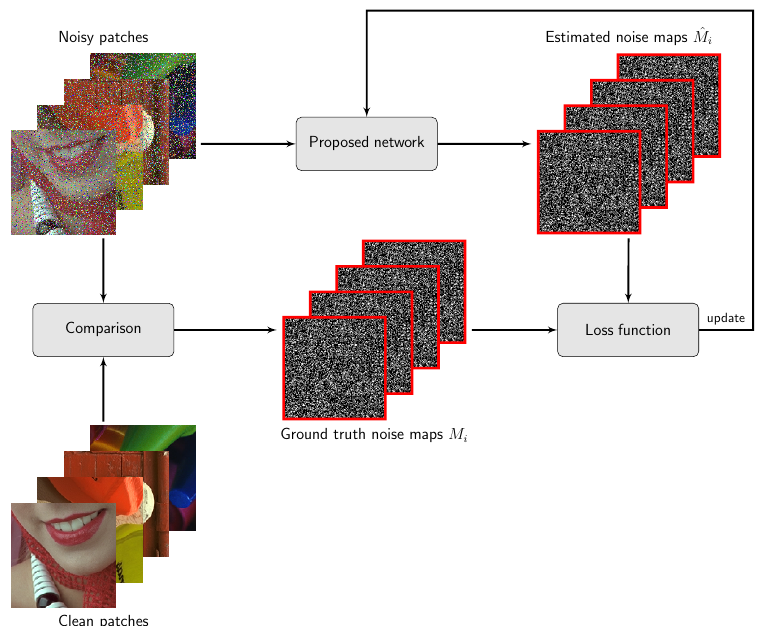
Figure 3. Training of the proposed Impulse Detection Convolutional Neural Network (IDCNN)